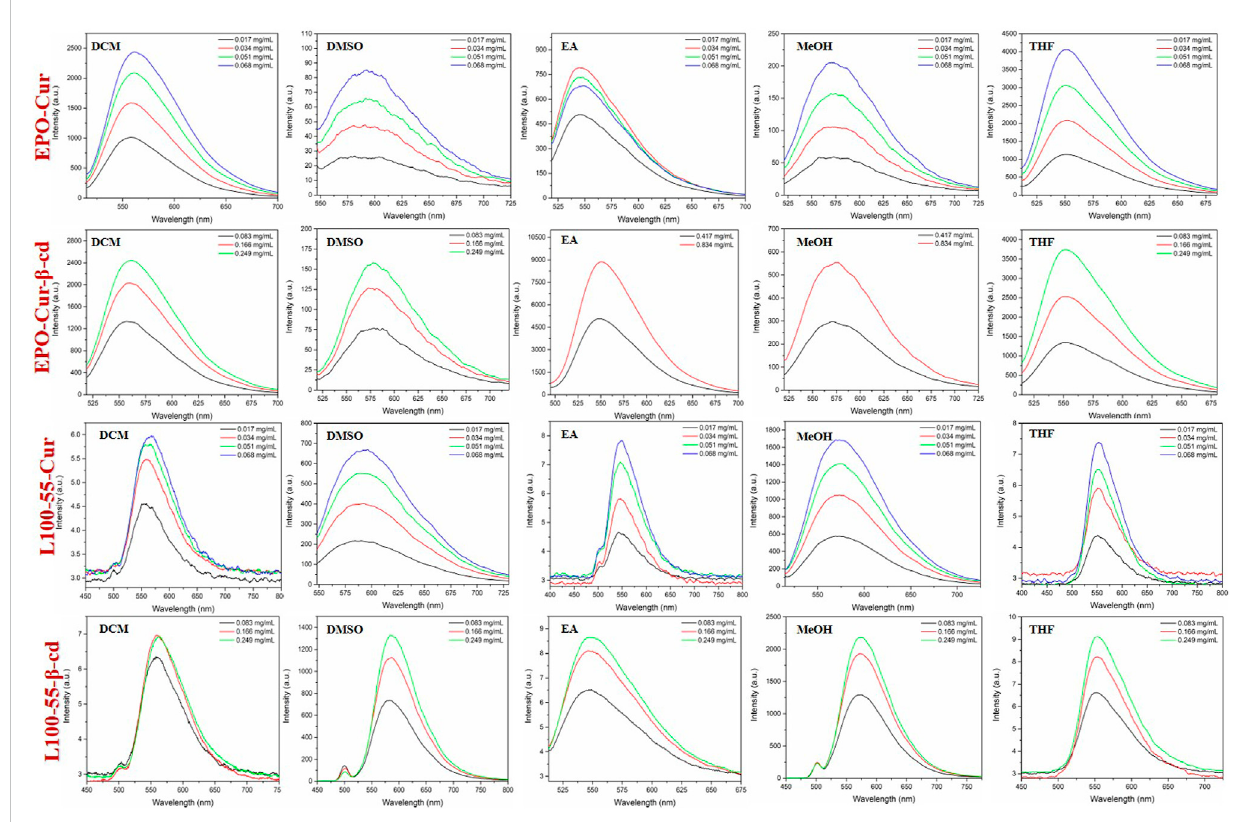
FIGURE 4 Fluorescence emission spectrum of complexes L100-55-Cur, L100-55-Cur- β -cd, EPO-Cur and EPO-Cur- β -cd in different